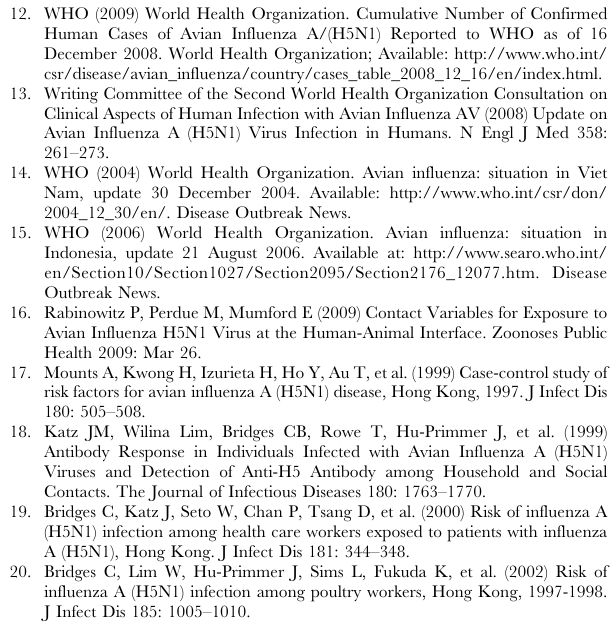
Table S1 Results of seroprevalence studies to determine the frequency of asymptomatic or subclinical infection and evaluate risk factors for H5N1 virus